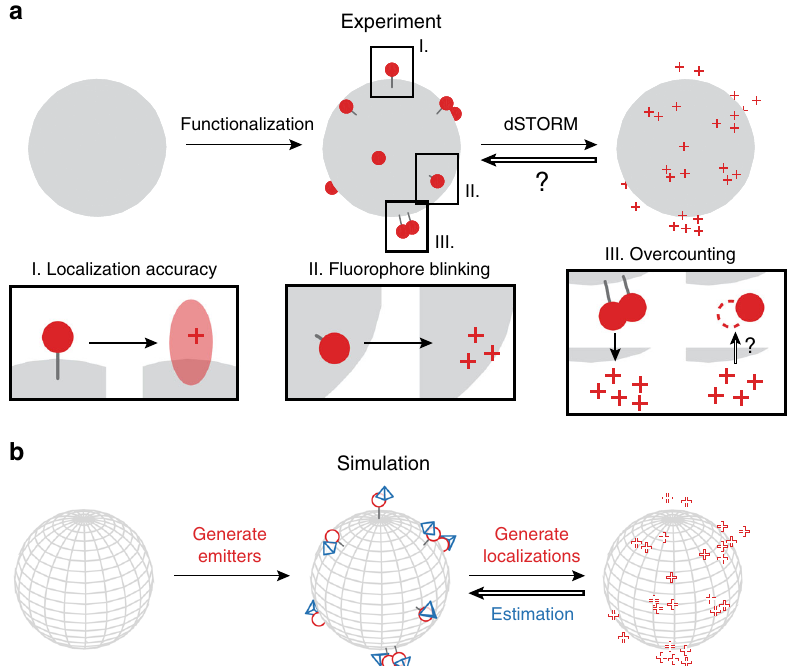
Fig. 1 Creating a model for dSTORM-mediated analysis of functional group distribution. a Schematic depiction of the steps involved in the observation of fl uorophore patterns on a spherical nanoparticle. Fluorescent dyes (red spheres) are, either chemically or physically, grafted to the nanoparticle (grey sphere) according to an unknown spatial distribution. The collection of localizations (red crosses) acquired during subsequent dSTORM imaging does not yield this spatial distribution exactly, due to a fi nite localization accuracy (I) and blinking of the dyes (II), leading to overcounting artefacts (III). b In our model, the steps mentioned in a can be mimicked in a fully controlled computational environment. The nanoparticle is functionalized with fl uorescent emitters (red spheres) following an arbitrary spatial distribution. Subsequently, the dSTORM imaging process is simulated, leading to a collection of localizations (red crosses) with known sources. From these localizations, the positions of the emitters are estimated (blue pyramids). By comparing emitter locations and the corresponding estimates, the performance of the estimation procedure is